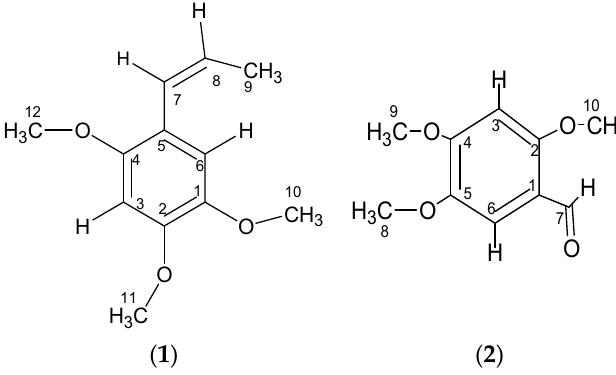
Figure 1. Structures of the compounds isolated from Piper cubeba L. berries.